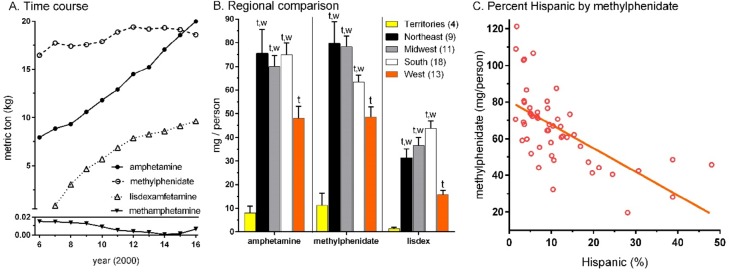
Total weight of amphetamine, methylphenidate, lisdexamfetamine, and methamphetamine in the US and territories from 2006 to 2016.(A). Regional analysis of these drugs in 2016. Lixdex: lisdexamfetamine. tp ≤ .001 versus the US Territories; wp < .05 versus the western states (B). Scatterplot depicting moderate association (R2 = 0.40) between percent of the state comprised of Hispanic citizens according to the 2015 US Census and population corrected use of methylphenidate (C).